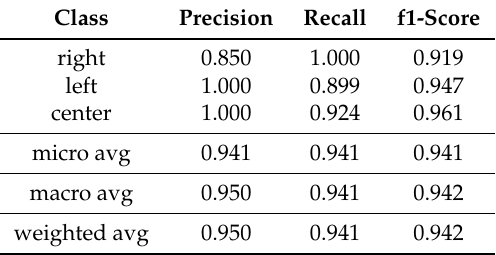
Table 1. Results of the second evaluation of the trained CNN